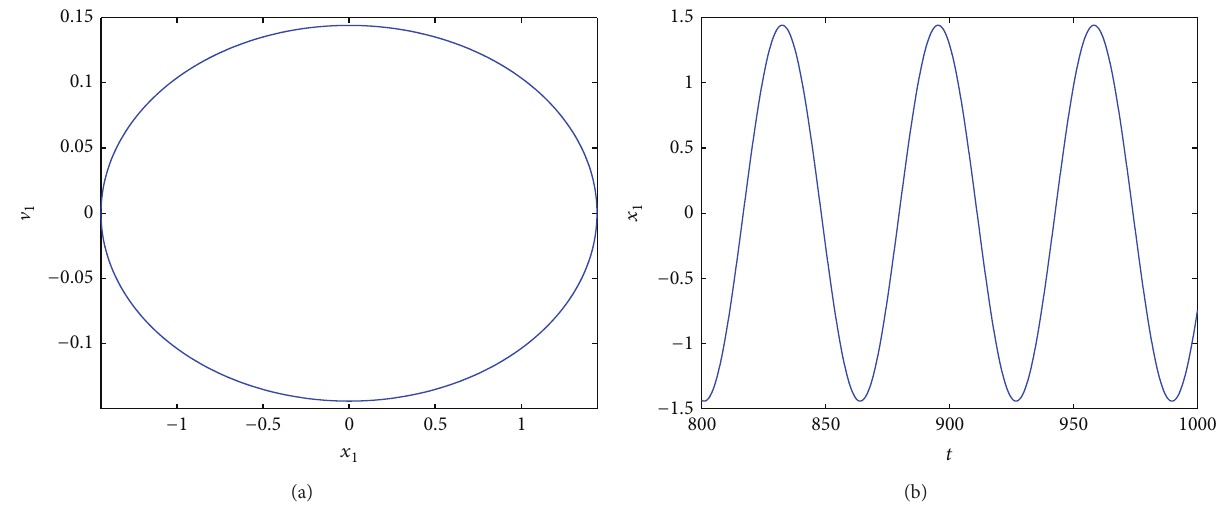
Figure 3: Double grazing period-1 motions of the system: (a) the phase portraits of oscillator 𝑀 1 ; (b) the time response of oscillator 𝑀 1